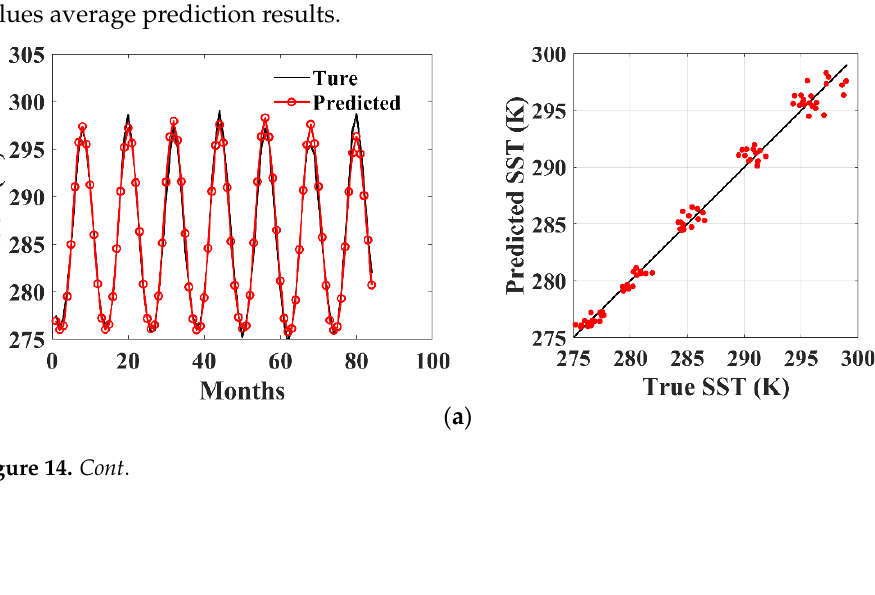
Table 5. Comparison of RMSE between different models.